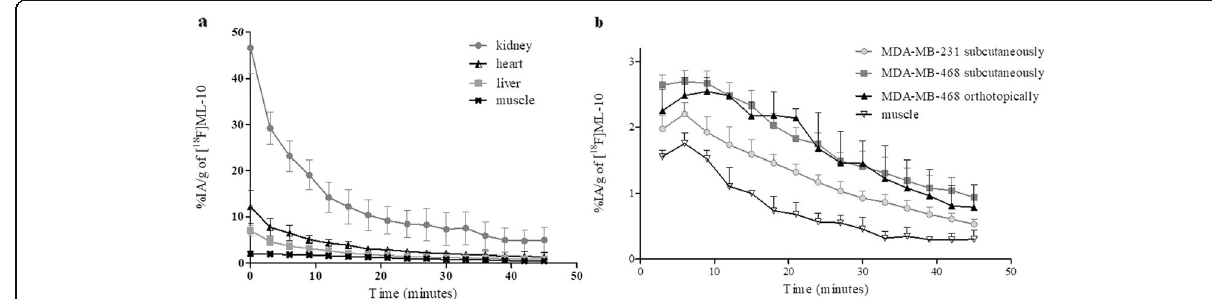
Fig. 6 Time activity curves after bolus injection of 29.5 ± 4.1 MBq [ 18 F]ML-10 of triple negative breast cancer models. a Time activity curves showing uptake of [ 18 F]ML-10 in the kidneys, liver, heart, and muscle over 45 min ( n = 6). b Time-activity curves showing uptake of [ 18 F]ML-10 in muscle, MDA-MB-231 xenograft tumor ( n = 3), MDA-MB-468 xenograft tumor ( n = 3), and MDA-MB-468 orthotopic tumor ( n = 3) over 45 min. Radioactivity was expressed as a percentage of the injected activity per gram of tissue (%IA/g). Data are presented as mean ±